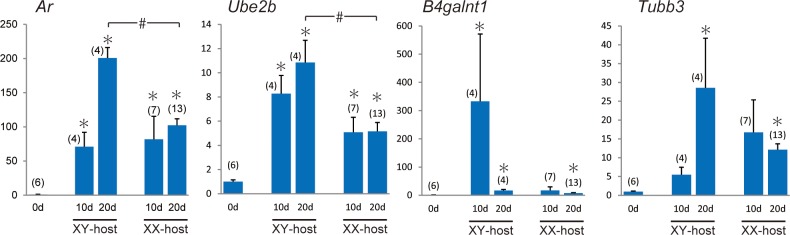
Expression profiles of AR and its target genes in grafted ovaries.Bar graphs showing temporal changes in the expression levels (y-axis) of Ar and AR-target genes, Ube2b, B4galnt1 and Tubb3, in ovarian grafts in XY- and XX-host on each day post-transplantation (x-axis). The data are expressed as means ± SEM. The expression levels on day 0 post-transplantation were set as 1.0 on the y-axis (*p<0.05 as compared with day 0; #p<0.05 as compared between different host groups, Steel’s test). The numbers in parentheses indicate the number of explants used at each stage.